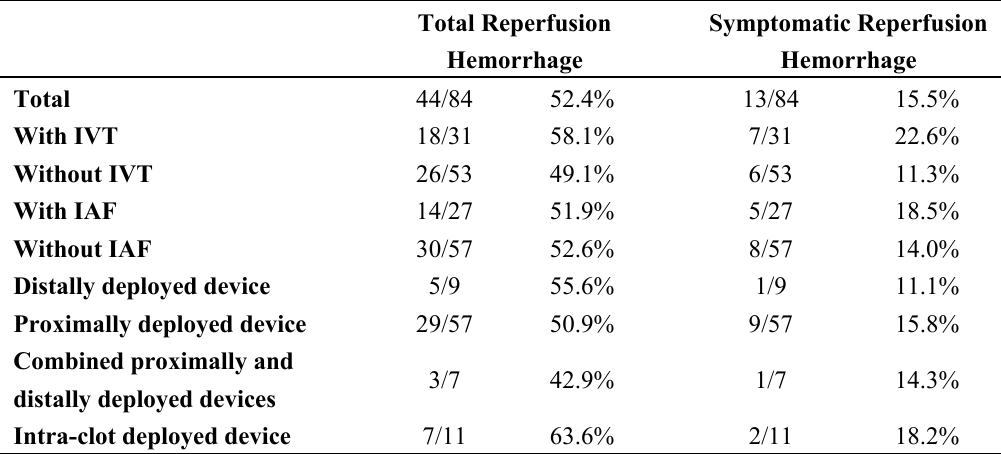
Table 3. Rate of reperfusion hemorrhage (total and symptomatic) stratified by type of device used and by adjunctive administration of fibrinolytic therapy. IVT, IV thrombolysis; IAF, IA fibrinolysis.